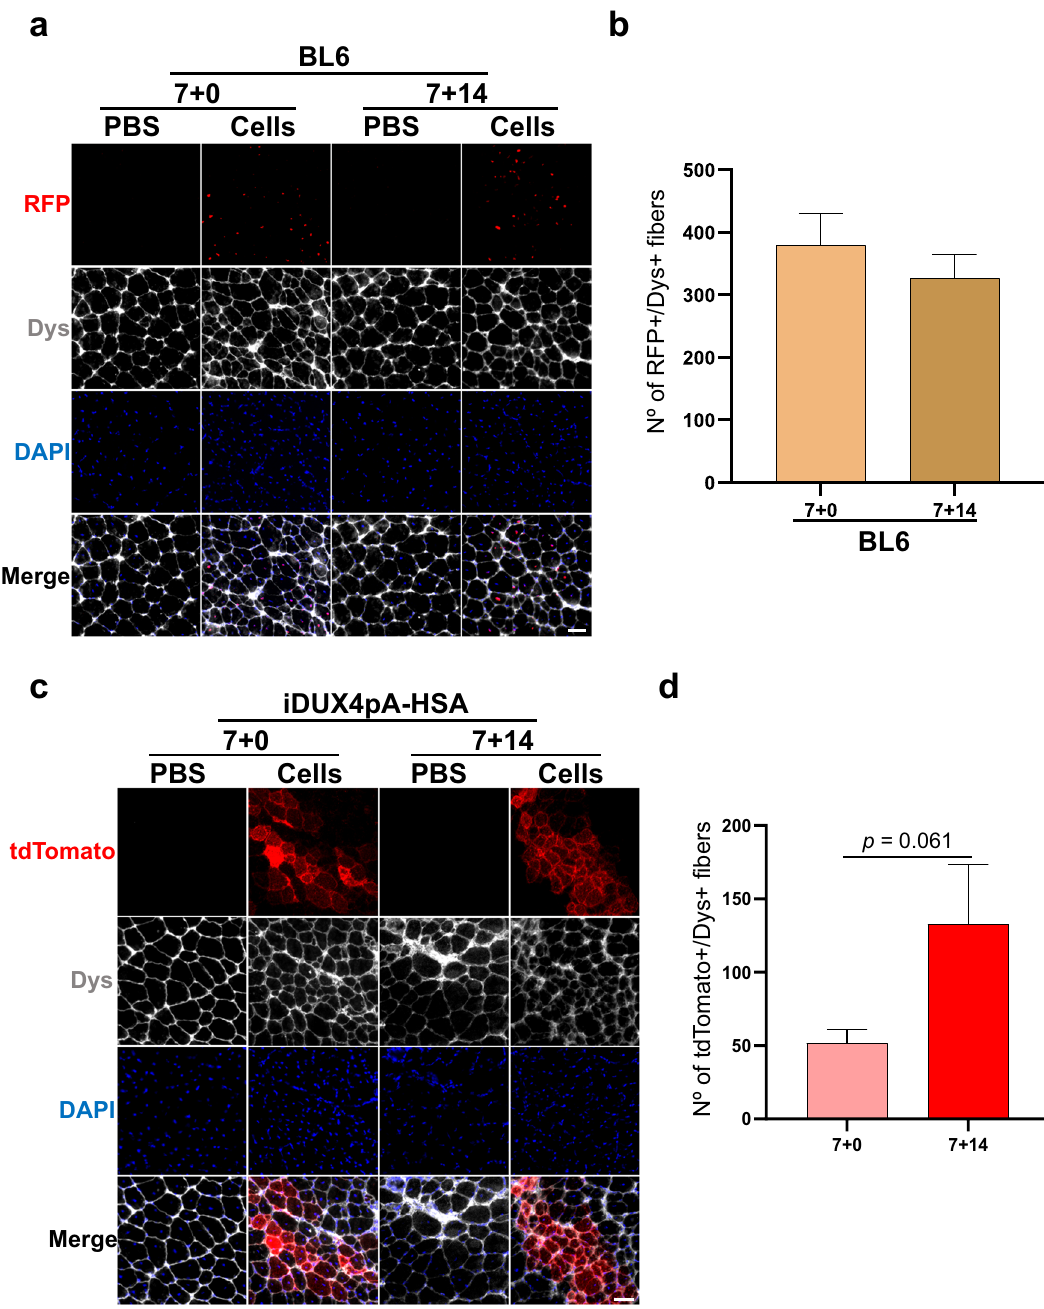
Fig. 3 Testing environment vs. cell autonomous effect of dox post-transplant. a Representative images show immunostaining for RFP (in red) and Dys (in gray) in TA muscles of BL6 mice that had been injected with PBS or Pax3-induced myogenic progenitors, and later fed with dox in a similar fashion as iDUX4pA-HSA 7 + 0 and 7 + 14 cohorts (Fig. 2a). DAPI stained nuclei in blue. Scale bar is 50 µm. b Graph shows engraftment quanti fi cation from a . Data are shown as mean ± SEM ( n = 7 for 7 + 0 and n = 7 for 7 + 14). c Representative images show immunostaining for tdTomato (in red), and Dys (in gray) in TA muscles of iDUX4pA-HSA mice that had been injected with PBS or 5000 satellite cells isolated from a mTmG mouse and fed with dox following the 7 + 0 and 7 + 14 dox regimen. DAPI stained nuclei in blue. Scale bar is 50 µm. d Graph shows engraftment quanti fi cation from c based on the number tdTomato + /Dys + myo fi bers. Data are shown as mean ± SEM ( n = 6 for 7 + 0 and n = 5 for 7 + 14). p = 0.061 by the Student ’ s t